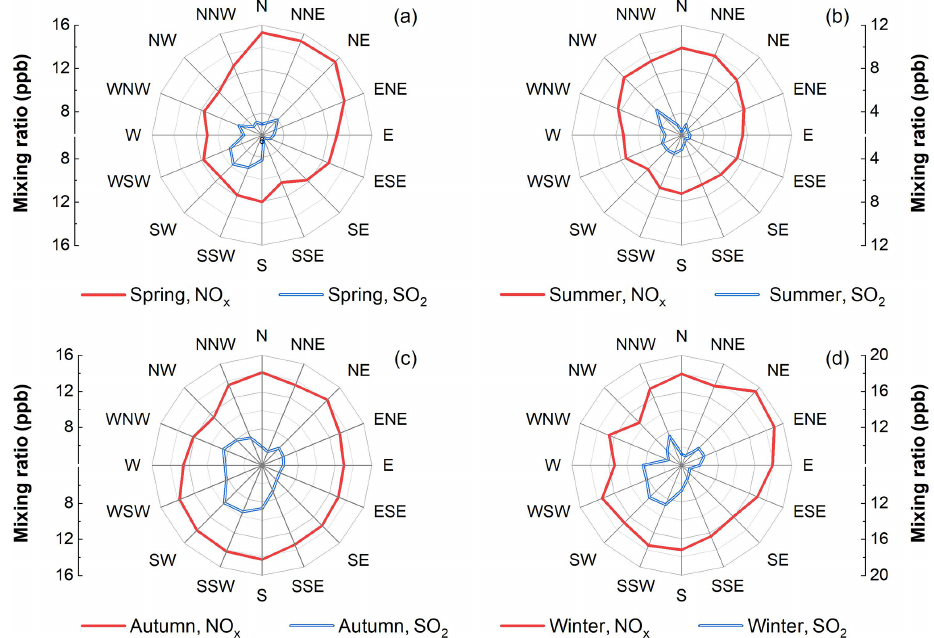
Figure 6. Seasonal distributions of NO x and SO 2 concentrations in different wind